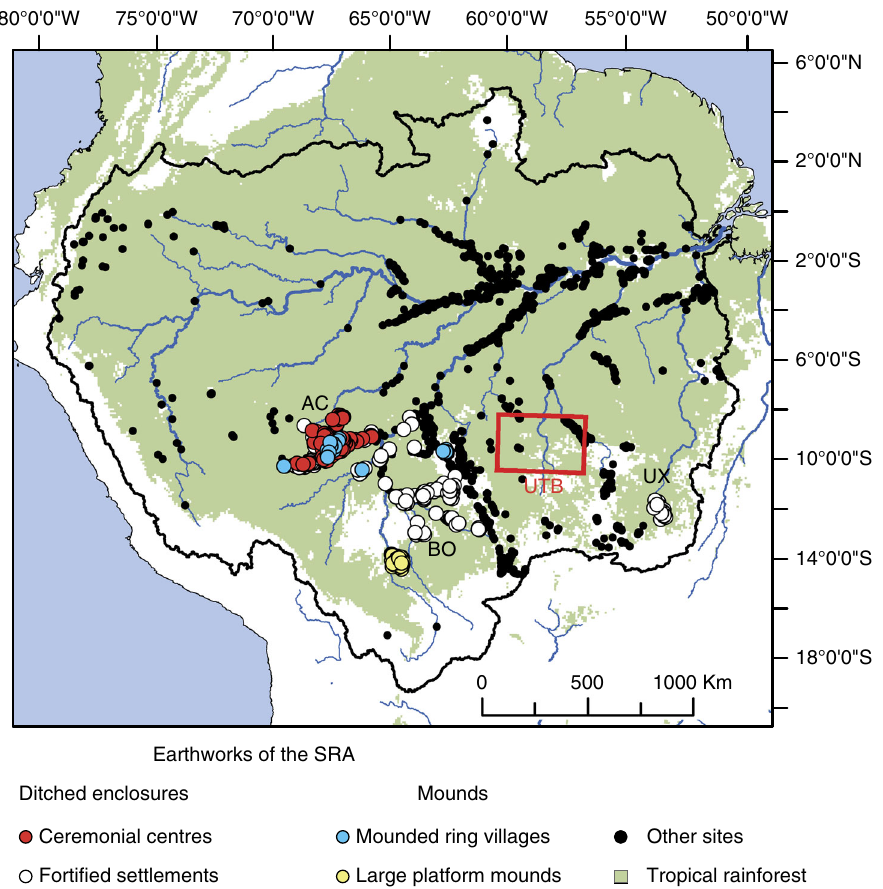
Fig. 1 Distribution of earthworks in the SRA and other sites in the Amazon 68,69 . Different categories of earthworks as per Supplementary Note 1. Sub- regions of the SRA discussed in the text: AC Geoglyphs of Acre, BO Ring ditches of Bolivia, UX Upper Xingu, UTB survey area in the Upper Tapajós Basin (the area delimited by the red box is shown in detail in Fig. 4). Scale bar = 1000